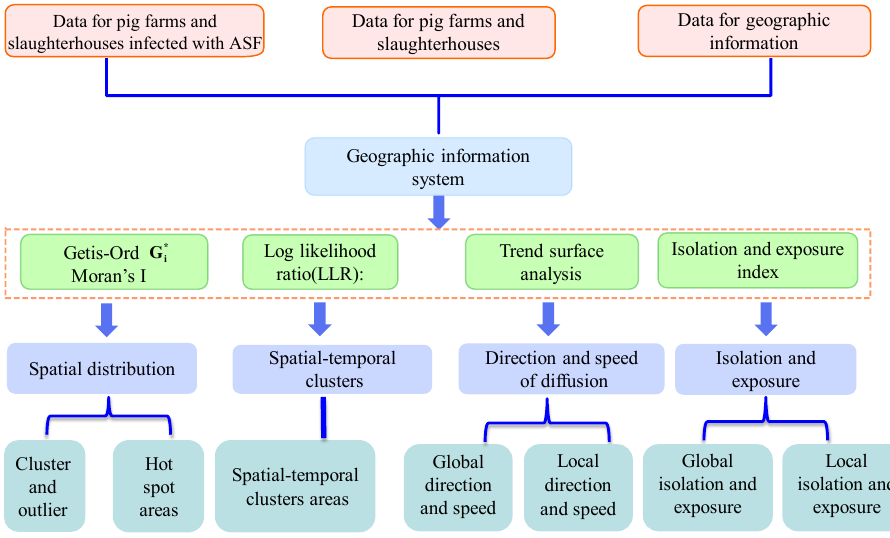
Figure 1. Technical analysis